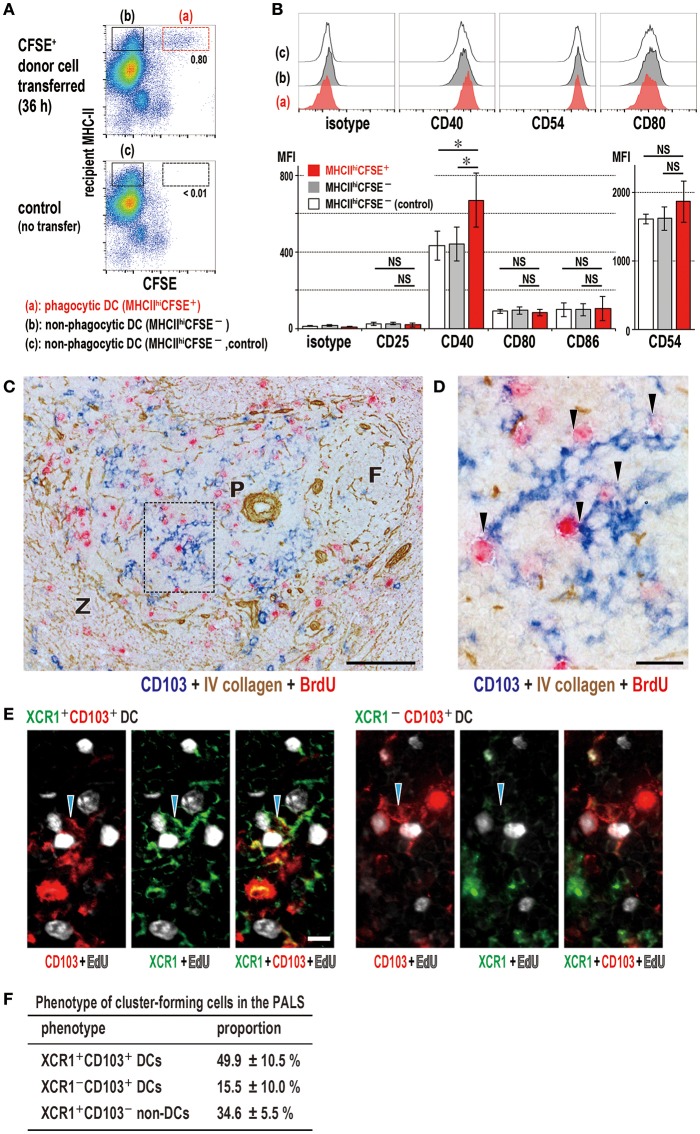
Activation state of phagocytic dendritic cells (DCs) and phenotype of DCs that cluster with proliferating cells in the PALS. (A,B) Upregulation of CD40 in XCR1+ DCs following phagocytosis. Phagocytic DCs were compared with non-phagocytic DCs in MHCIIhigh gates with/without donor cell transfer (mean ± SD, n = 4 rats each, *P < 0.05, NS, not significant). (C,D) Three-color immunostaining of the spleen 2 days after DST for CD103 (blue), BrdU (red), and type IV collagen (brown). (C) Many CD103+ DCs (blue) and BrdU+ proliferating cells (red) are present in the PALS (P). Scale bar = 100 μm. F, lymph follicle; Z, marginal zone. (D) Inset of A showing cluster formation (arrowheads) of recipient DCs (blue) with BrdU+ cells (red). Scale bar = 20 μm. (E) Three-color immunofluorescence staining of the PALS for XCR1 (green), CD103 (red), and EdU (white) 2 days after DST, showing clusters (arrowheads) of XCR1+CD103+ (left panels) or XCR1−CD103+ (right panels) DCs with EdU+ proliferating cells (white). Scale bar = 10 μm. (F) Proportion of cluster-forming cells in the PALS, showing ~50, ~15, and ~35% were XCR1+CD103+ DCs, XCR1−CD103+ DCs, and XCR1+CD103− non-DCs, respectively (mean ± SD, n = 3 rats each, *P < 0.05).